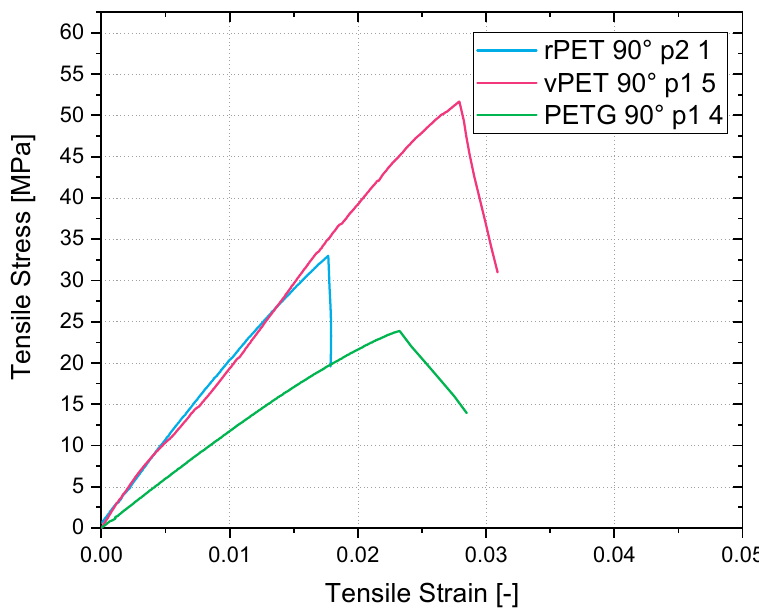
Figure 15. Stress–strain diagram at 90° bead orientation.